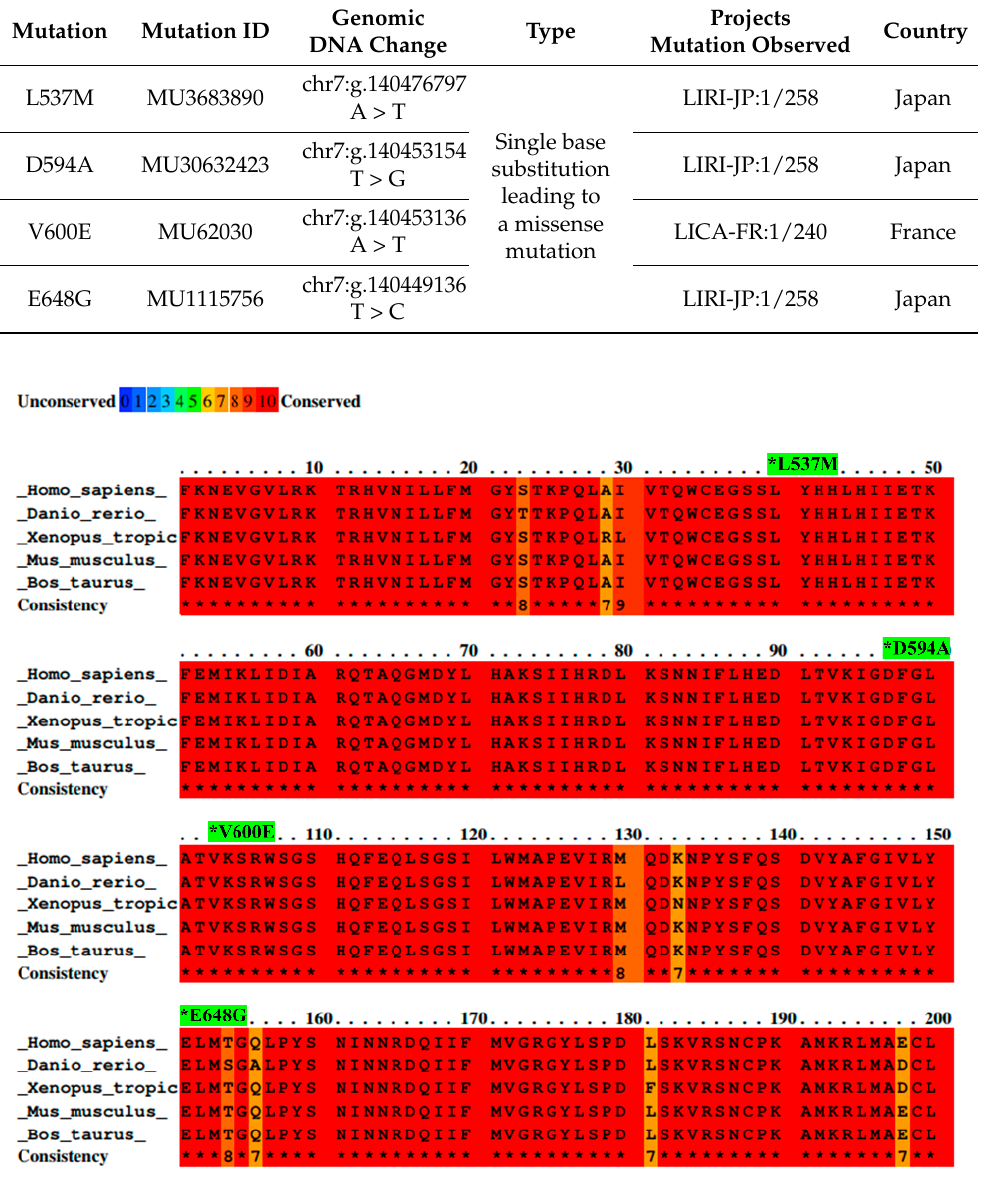
Figure 1. Alignment of BRAF amino acid sequences from different species with mutation sites indicated as *. Sequence alignment was performed between species— Homo sapiens, Mus musculus, Bos taurus, Danio rerio , and Xenopus tropicalis —by PRALINE software. Results are shown as a color-coded pattern. The scoring scheme ranges from 0 (for the least conserved alignment position) (in blue) up to 10 (for the most conserved alignment position) (in red). BRAF mutations selected for study have exhibited the highest conservation score between species.